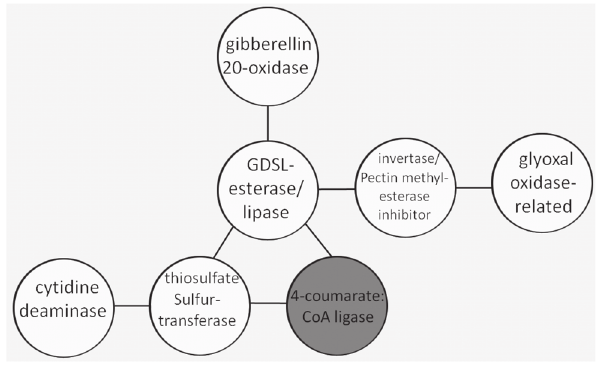
Figure 6. Co-Expression analysis. The ATTED-II database of genes co-expressed in Arabidopsis was utilized to identify potential interac- tions among the list of 66 targeted genes (see text). Circle with gray background indicates gene that is up-regulated, circles with white background indicate down regulated genes. A line connecting two genes means a mutual rank value of ,